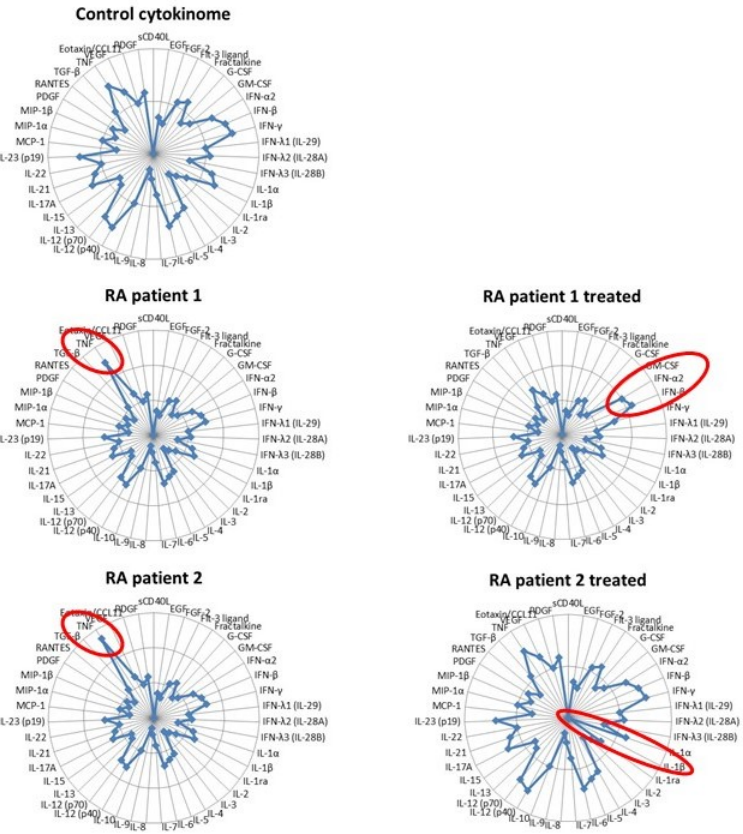
Figure 3. The multidimensional compass of inflammation. Radar plot showing the hypothetical expression levels of 43 cytokines/chemokines in the Control and two RA patients before and after anti-TNF therapy.